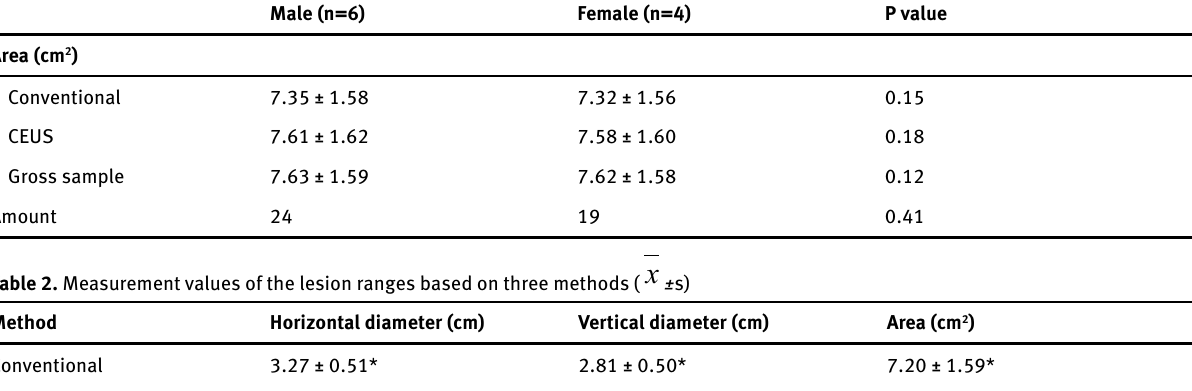
Table 1 . Comparisons of the areas and number of ablation lesions between genders based on the three different measurement methods. Male (n=6)